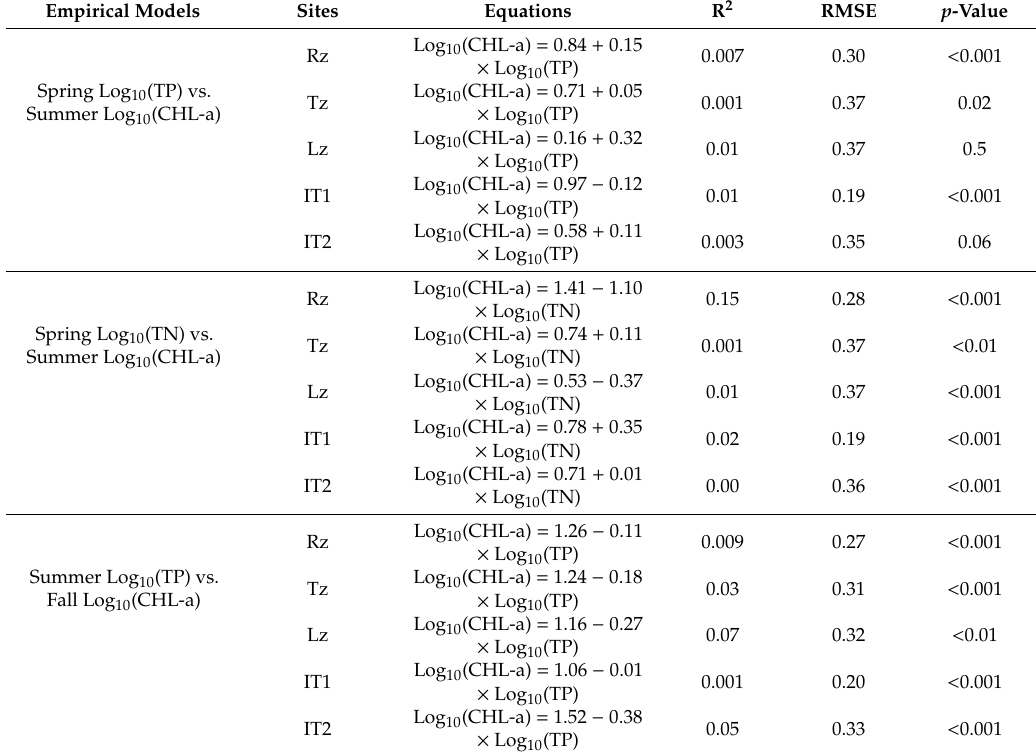
Table 4. Empirical Models and equations of Log 10 (CHL-a) vs. Log 10 (TP) and Log 10 (CHL-a) vs. Log 10 (TN) in the Daecheong Reservoir (data used from 2000–2018; Rz: riverine zone, Tz: transitional zone, Lz: lacustrine zone, IT1: drinking water intake tower 1, IT2: drinking water intake